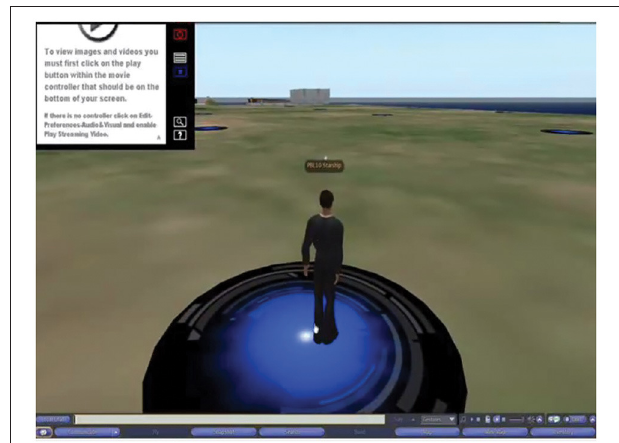
FIGURE 8 | Each PBL group was set up with their own unique avatar. Either of the two students trained to use SL would log in, and their avatar would appear on their assigned holodeck, projected onto the whiteboard. Once the group was ready, they launched the